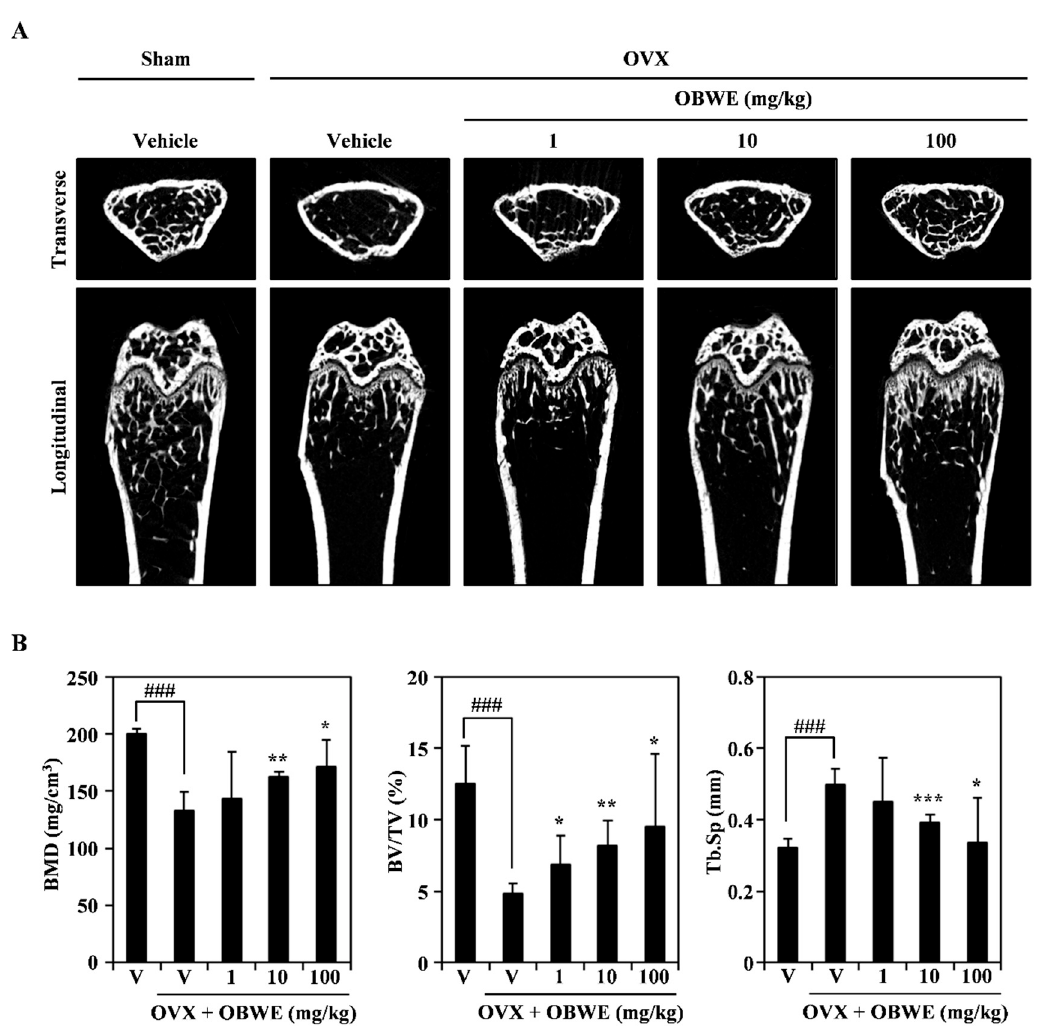
Figure 6. OBWE prevents OVX-induced bone loss in vivo. The effect of OBWE on OVX-induced bone loss was investigated in mice. ( A ) Micro-CT analysis-based images show transverse and longitudinal images of sham and OVX bone at 1 mg, 10 mg, and 100 mg/kg from left to right. ( B ) Bone mineral density (BMD), percent bone volume ratio (BV/TV), and trabecular separation (Tb. Sp) of femur measurements by 3D images analyzer. ### p < 0.001 (versus the sham group); * p < 0.05; ** p < 0.01 (versus the OVX group).